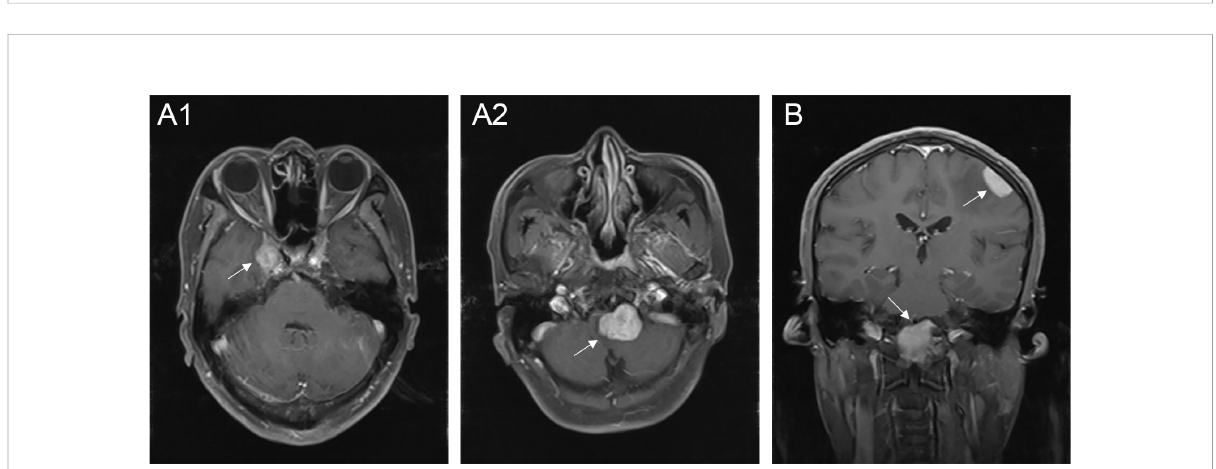
FIGURE 4 Multiple lesions of CNS-RDD in different intracranial parts. (A1, A2) Axial postcontrast T1WI showed enhanced multiple lesions (arrow) in the right parasellar and the clivus of one patient. (B) Coronal postcontrast T1WI showed enhanced multiple lesions (arrow) in the left convex and the clivus.